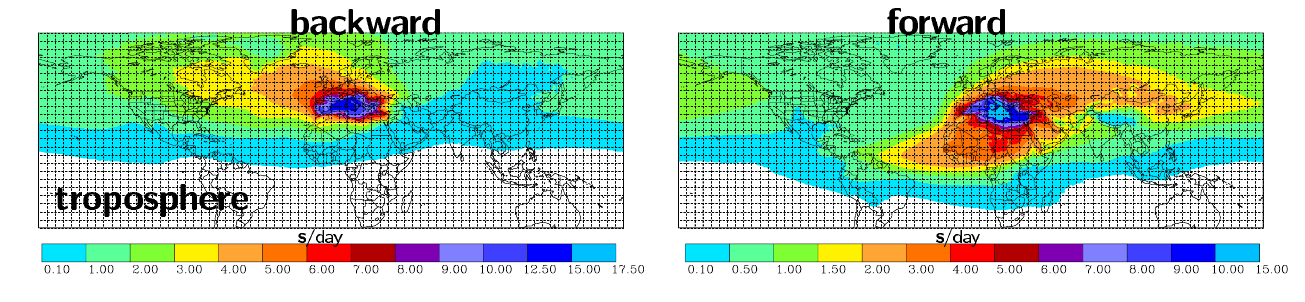
Fig. 4. 90-d residence